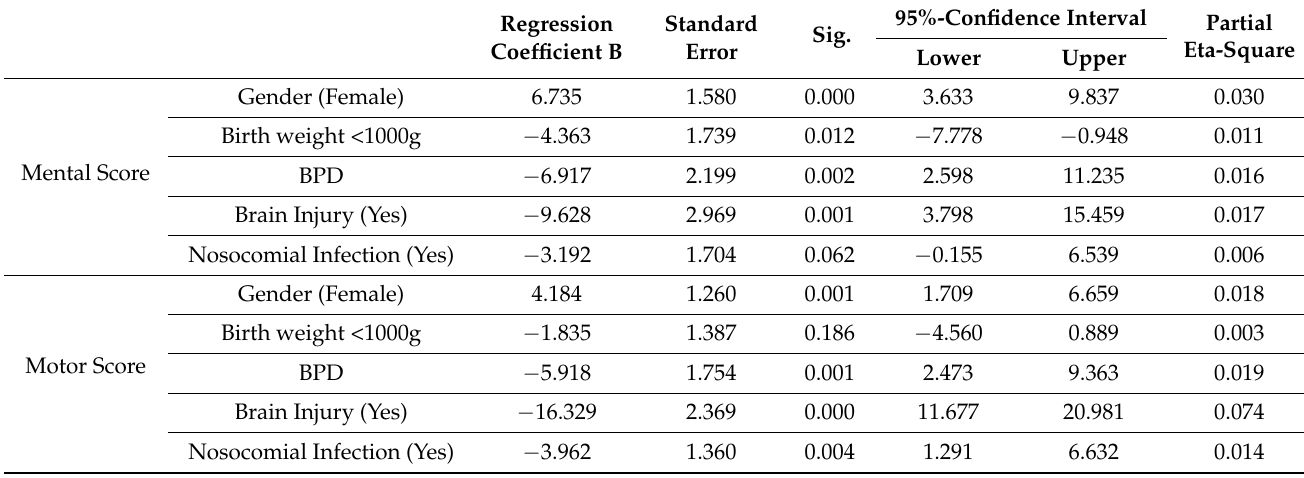
Table 1. Regression model for the influence of nosocomial infections on neurodevelopmental